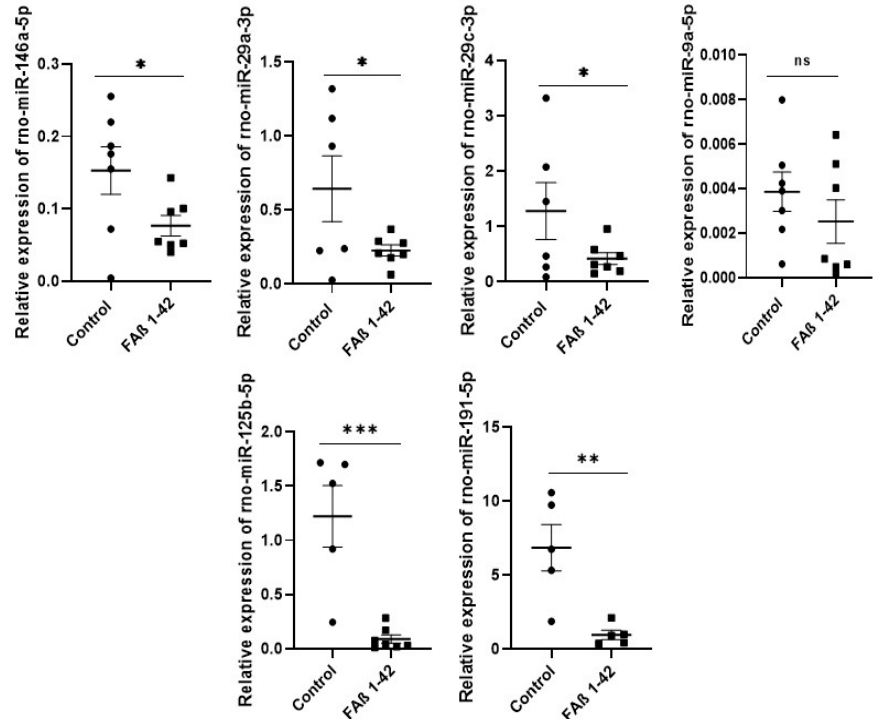
Figure 4. Relative expression of circulating miRNA-146a-5p, miRNA-29a-3p, miRNA-9a-5p, miRNA-29c-3p, miRNA-125b, miRNA-191-5p in serum of rats infused with 2.5 µg/µL of FA β 1-42 peptide solution. Serum samples were collected 21 days post-infusion. MiRNAs were extracted and quantified by qRT-PCR. Data are represented as mean ± SEM of 7–8 samples evaluated in triplicate. Statistical comparisons between FA β 1-42 and PBS group were performed using the Mann–Whitney test. * p ≤ 0.05 , ** p ≤ 0.01, *** p ≤ 0.001.